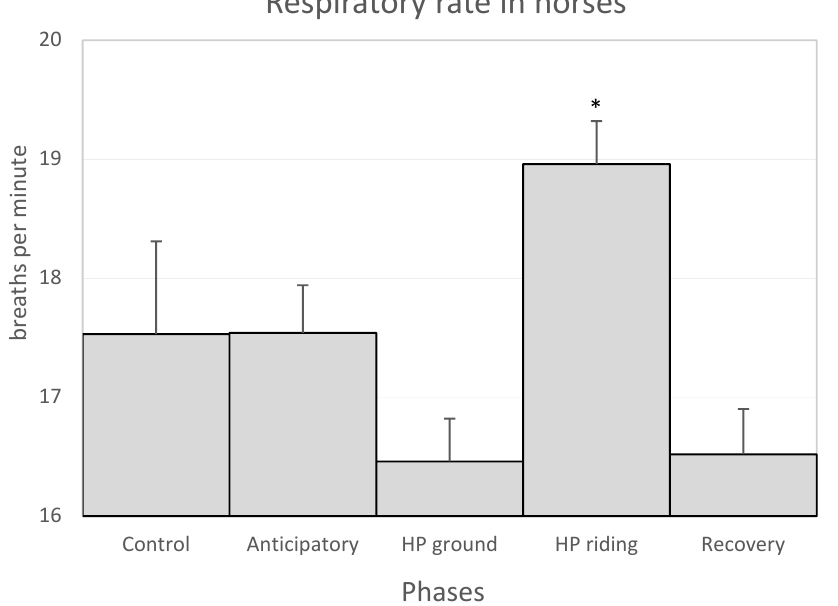
Figure 1. Mean values + SEM of the heart rate of the horses in the control and the anticipatory phases, the HP ground and HP riding phases (horse-patient interaction on the ground and on horse- back, respectively) and the recovery phase. No significant differences were observed between the phases.